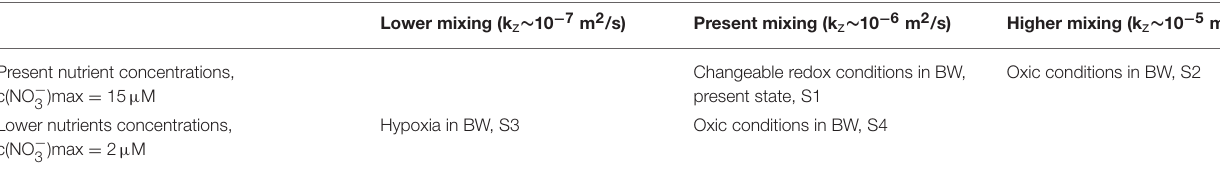
TABLE 3 | Parameters of studied scenarios (S1–S4) used in numerical